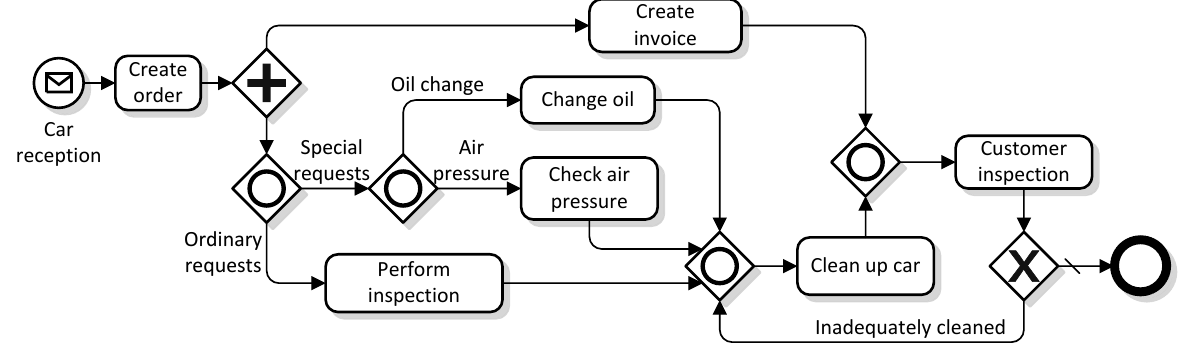
Figure 2. Car service